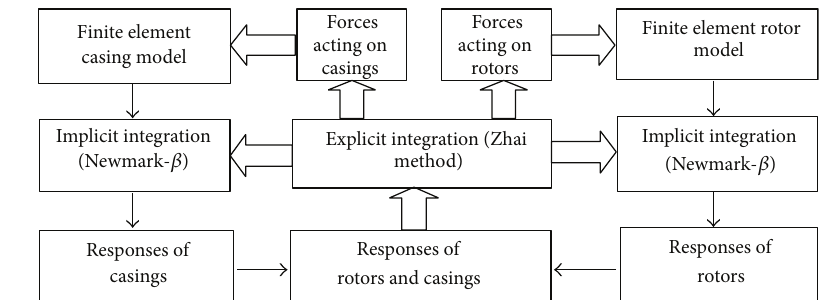
Figure 4: Solving flow for rotor-support-casing coupling dynamics.